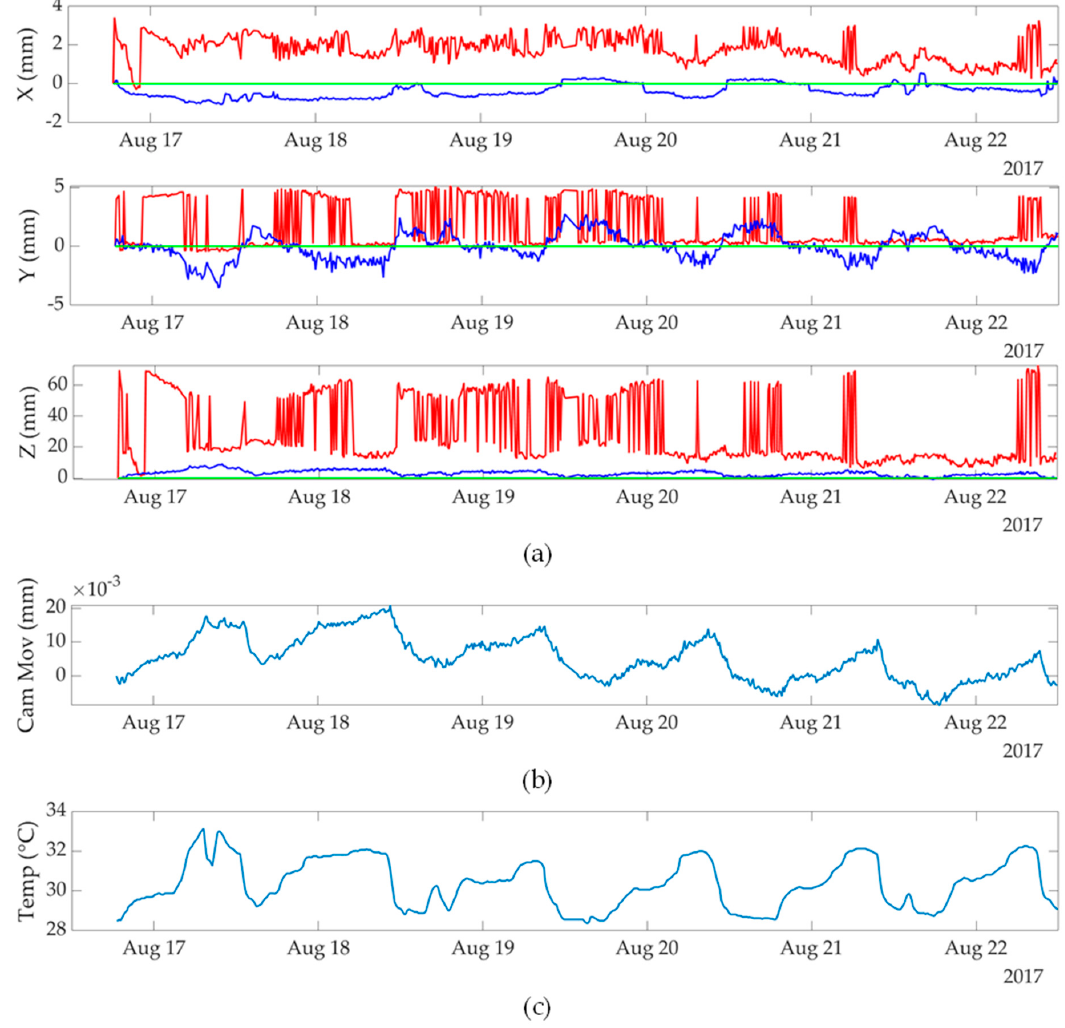
Figure 5. Evaluations of static target displacements in long-term indoor monitoring process using a moving camera: ( a ) static target displacement measurements in the X, Y and Z directions. For the legends, a stationary calibration target is used as the camera movement compensation in the red plots, a stationary calibration target with an attached CX-1 tilt sensor is used as the camera movement compensation in the blue plots, and the green plots show the ground truth target displacements; ( b ) the synchronized and averaged camera movements at each camera capture in the monitoring process; ( c ) the temperatures at each camera capture in the monitoring process.